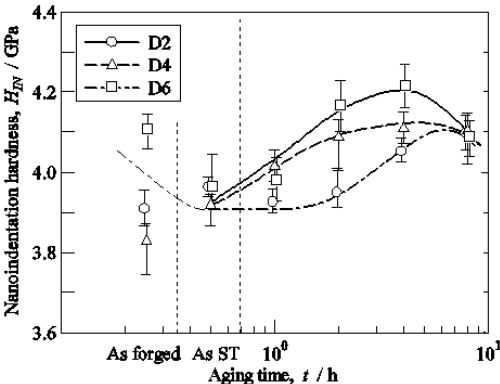
Figure 7. Measured nanoindentation hardness of the ABD alloys following heat treatment: forging, solution treatment, and isothermal aging at 1123 K.